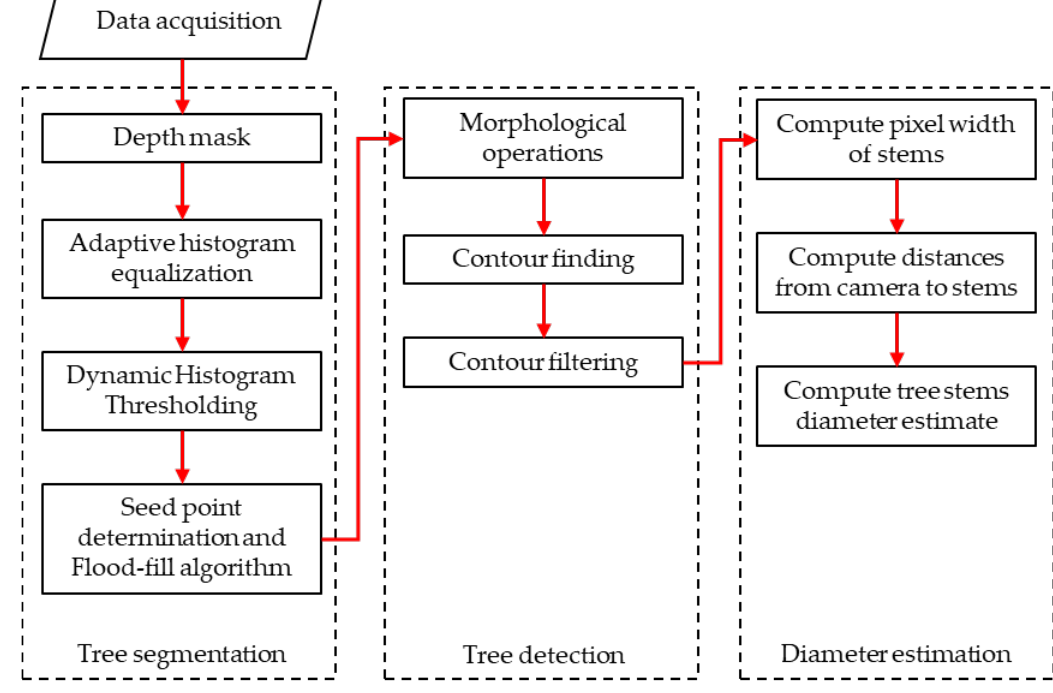
Figure 2. Willow tree algorithm flowchart.